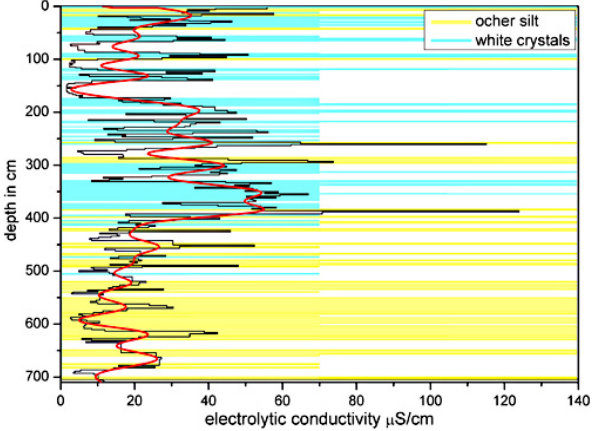
Fig. 6. Electrolytic conductivity of the quasi-continuous 2cm- aliquots (black line) together with the stratigraphy of particles qual- itatively observed in the melted aliquots. The conductivity data was transferred onto an equidistant record with a resolution of 0.1cm, where gaps were linearly interpolated before a 25cm-running aver- age of the equidistant data was created (red line).